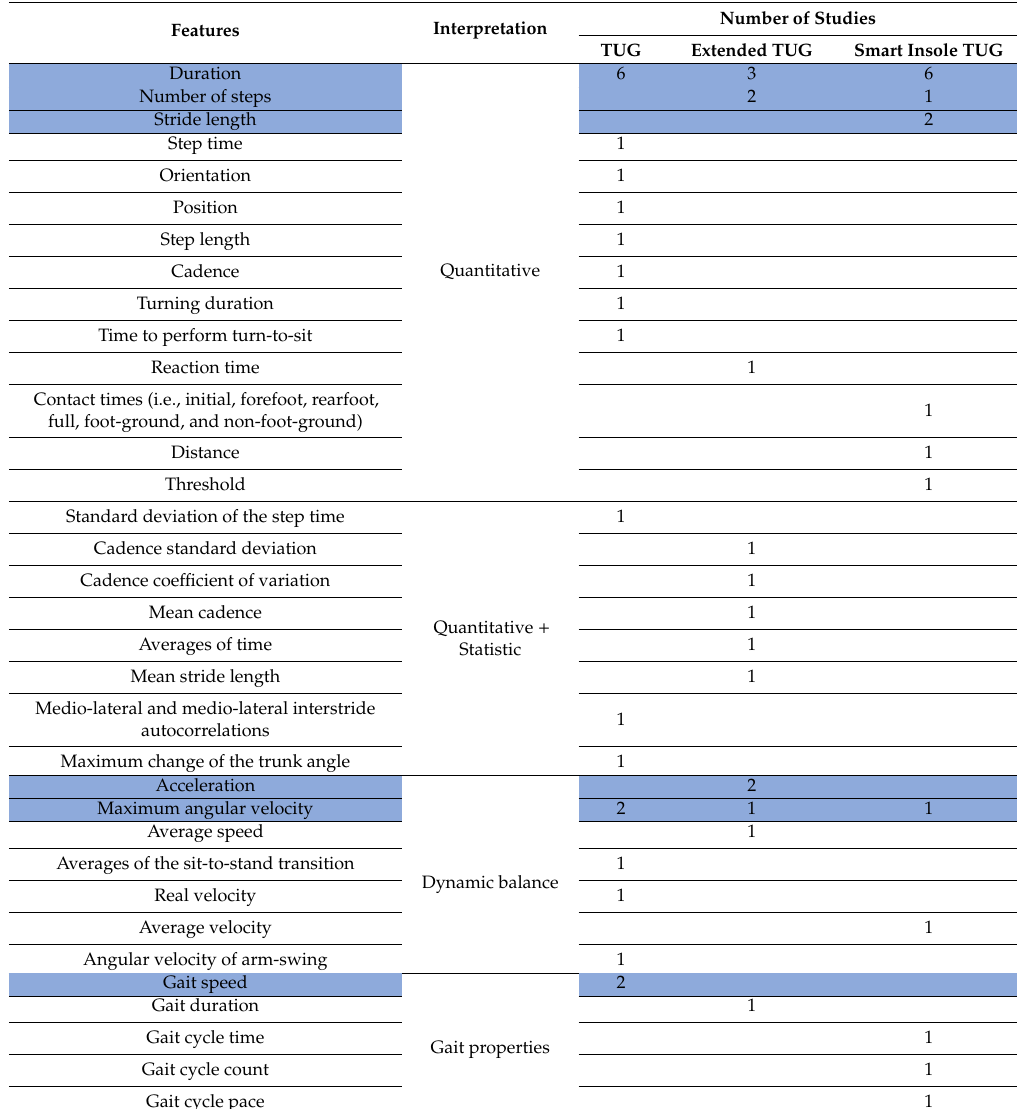
Table 2. Features relative to the di ff erent types of Timed-Up and Go